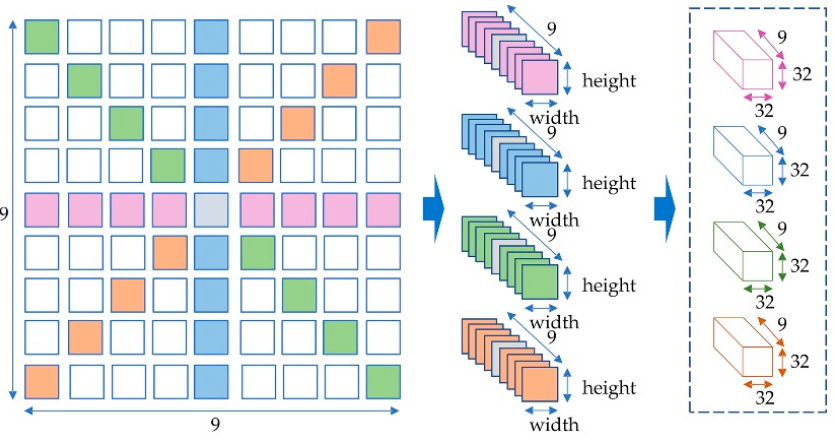
Figure 3. The process of generating EPI